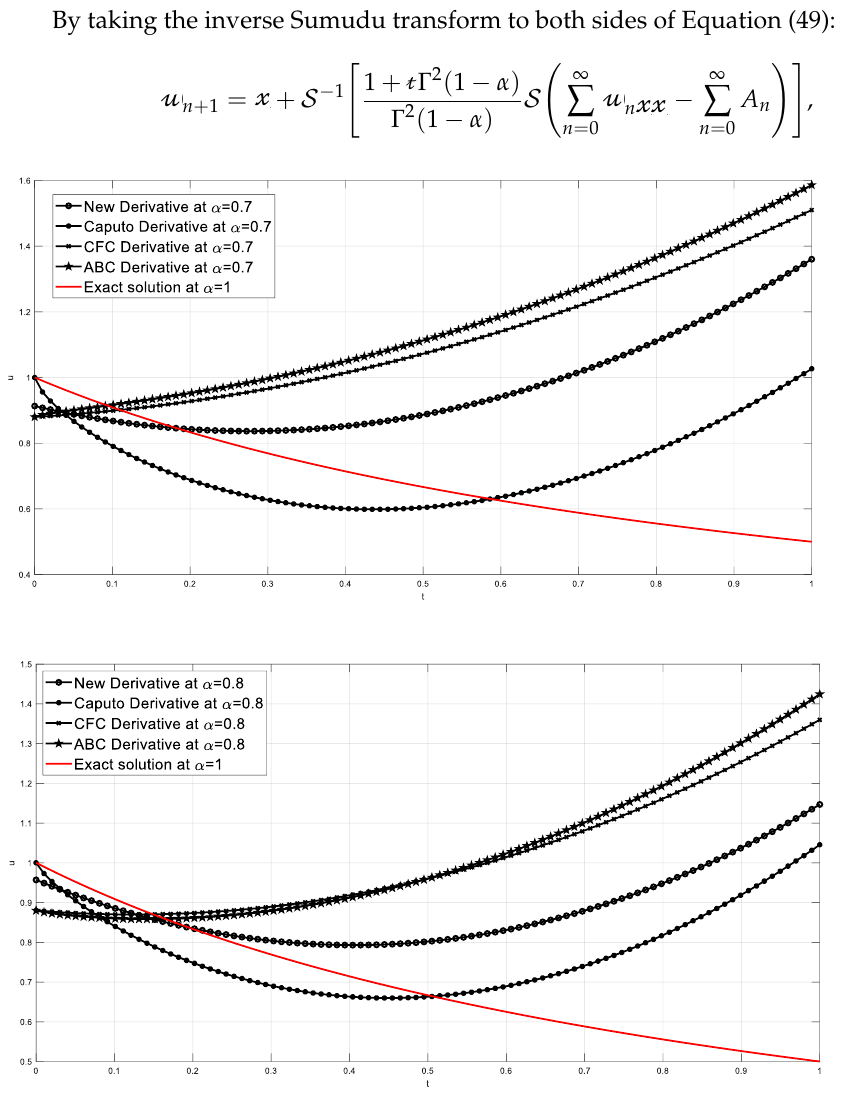
Figure 1. The graphs of the exact solutions among different values of 𝓉 , 𝛼 for the exact solution of Equation (45), exact solution of Equation (48), exact solution of Equation (50), exact solution of Equation (52) and the exact solution of Equations (45), (48), (50) and (52) at 𝛼 = 1 .